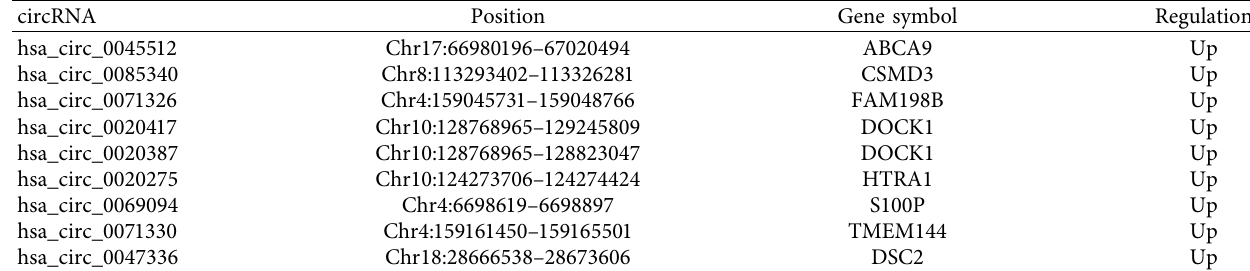
circRNA, circular